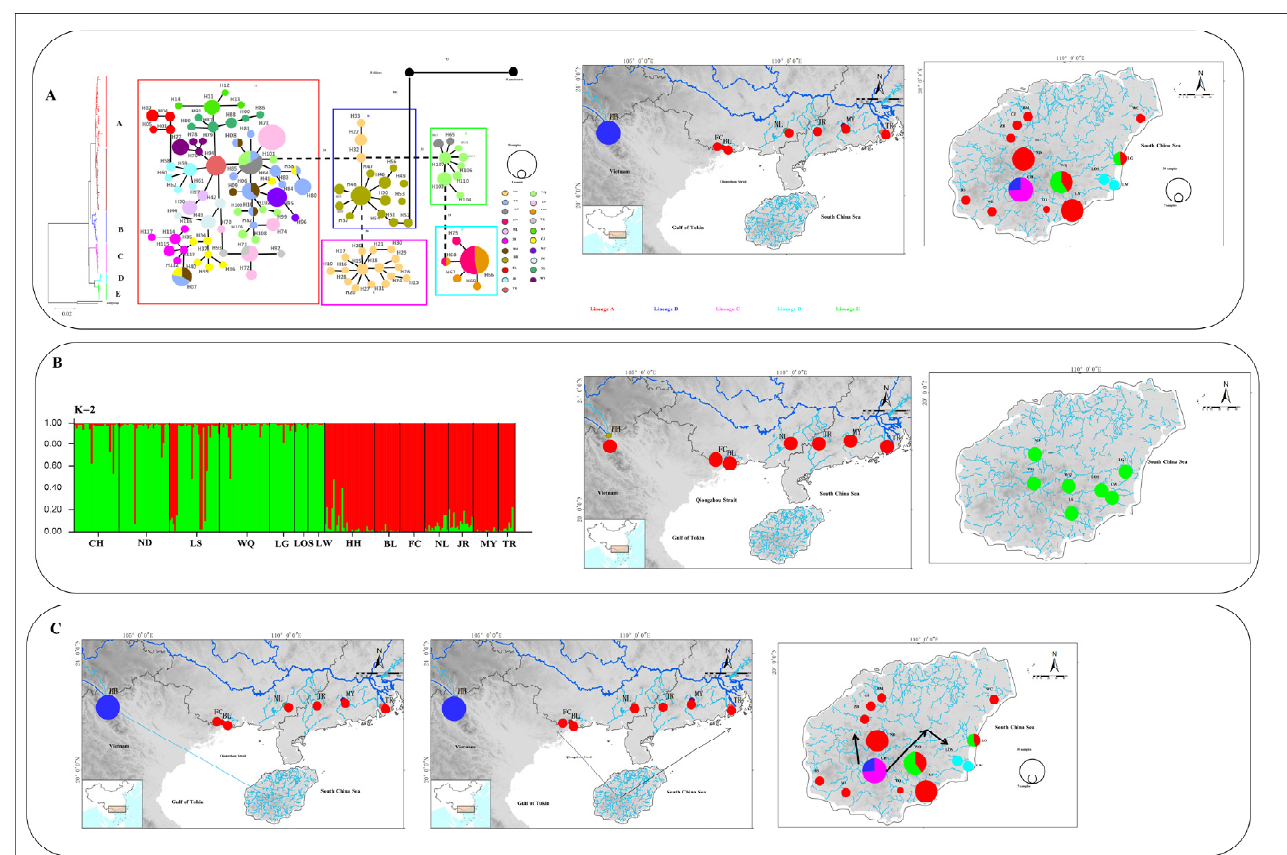
Figure 8. ( A ) Phylogenetic tree, the haplotype network, and the distribution of the major mtDNA lineages. ( B ) STRUCTURE based on microsatellite data and the distribution of groups (K = 2) revealed in the STRUCTURE. ( C ) The colonization history of O. hainanensis . Arrows represent migration routes. Lineages A–E is shown in the map with corresponding colors for each lineage.